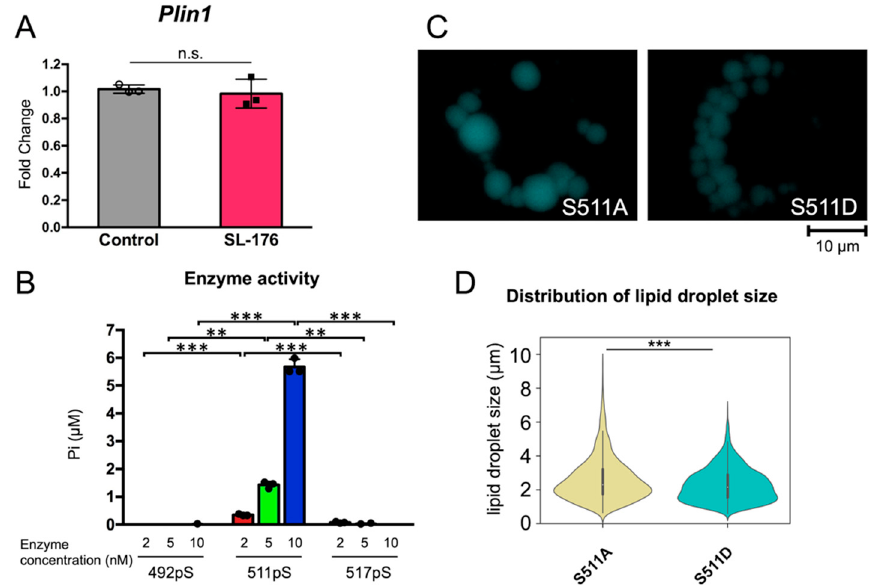
Figure 6. PPM1D regulated lipid droplet formation via dephosphorylation of perilipin 1 at Ser511 residue. ( A ) The expression of white adipocyte marker gene did not change due to the inhibition of PPM1D in mature 3T3-L1 adipocytes. The mRNA expression of perilipin 1 after 7 days of inhibition of PPM1D in mature 3T3-L1 white adipocytes. The mRNA expression level was measured using RT-qPCR. The data was normalized with actin mRNA expression and expressed as fold change. Data represents the mean ± S.D. of three independent experiments. Significance was analyzed by using Student’s t-test; n.s., not significance. ( B ) The in vitro enzymatic activity of His-mouse PPM1D against phosphorylated perilipin 1 peptides. Data represents the mean ± S.D. of three independent experiments. Significance was analyzed by using Student t -test. ** p < 0.01, *** p < 0.001. ( C ) Lipid droplet imaging of 3T3-L1 cells that were transfected with perilipin 1 mutants. ( D ) Violin plot of size distribution of lipid droplets of 3T3-L1 adipocytes, overexpressed perilipin 1 mutants. Data were obtained from three independent experiments of 3T3-L1 cells transfected with perilipin 1 S511A or S511D. Significance was analyzed by using Wilcoxon Rank Sum Test. *** p < 0.001.